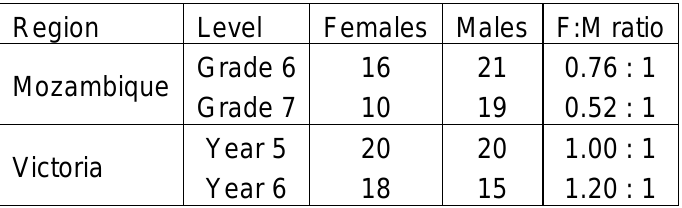
Table 4. Distribution frequency of females and males in photos and drawings.